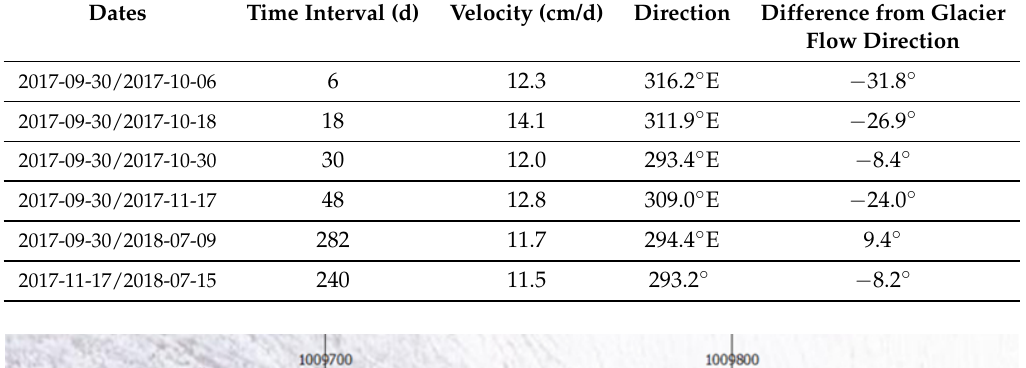
Table 6. Distance covered by CR9 between two successive positions and the corresponding velocity.